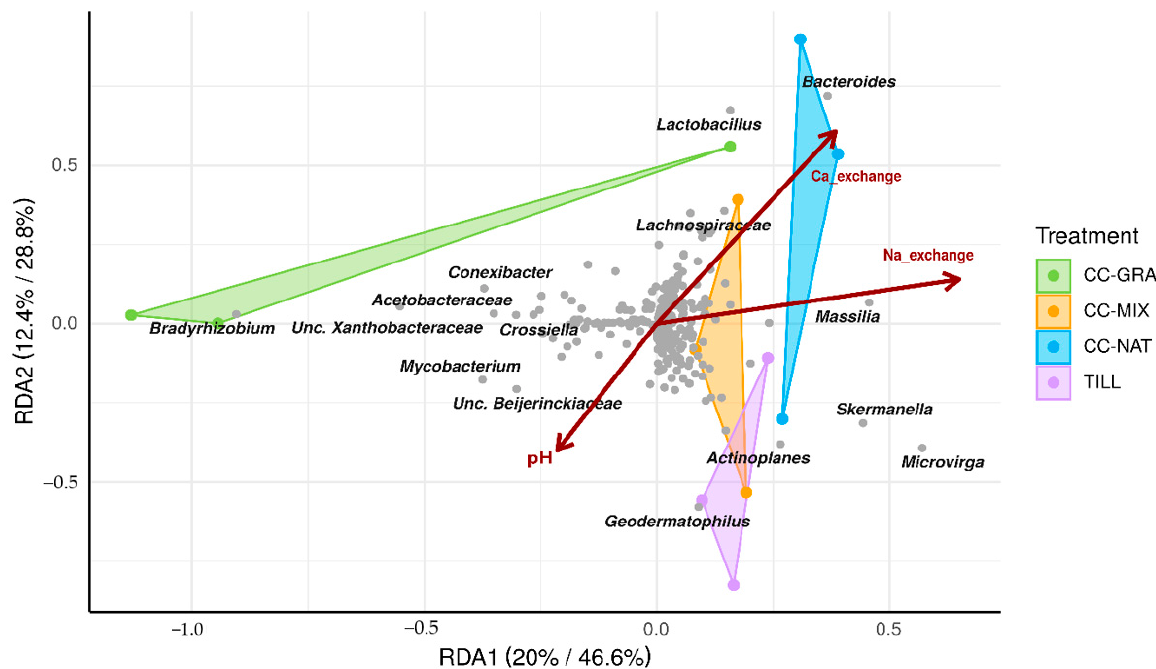
Figure 6. Transformation-based redundancy analysis (tb-RDA) triplot showing variation in bacterial community composition at the general level in an olive orchard soil under different cover crop managements (TILL: tillage, CC-GRA: sown cover crop with gramineous and CC-MIX: sown cover crop with a mixture of species) and CC-NAT (cover crop with spontaneous vegetation) constrained to the exchangeable Na and Ca and pH environmental variables. The relative contribution (eigenvalue) of each axis to the total inertia in the data and to the constrained space only, respectively, are indicated in percent at the axis titles. The grey points indicate the centroid points of the bacterial genera in the ordination diagram with the 15 most extreme genera indicated.